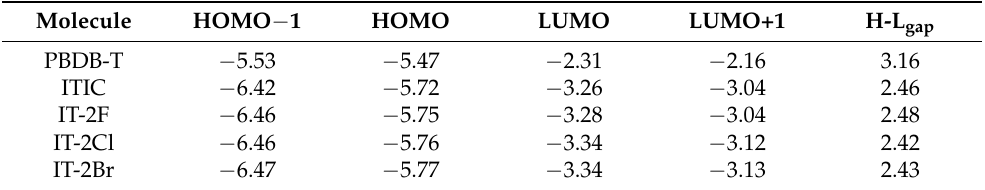
Table 2. The selected molecular orbital energies (in eV), HOMO-LUMO gap (H-Lgap, in eV) for